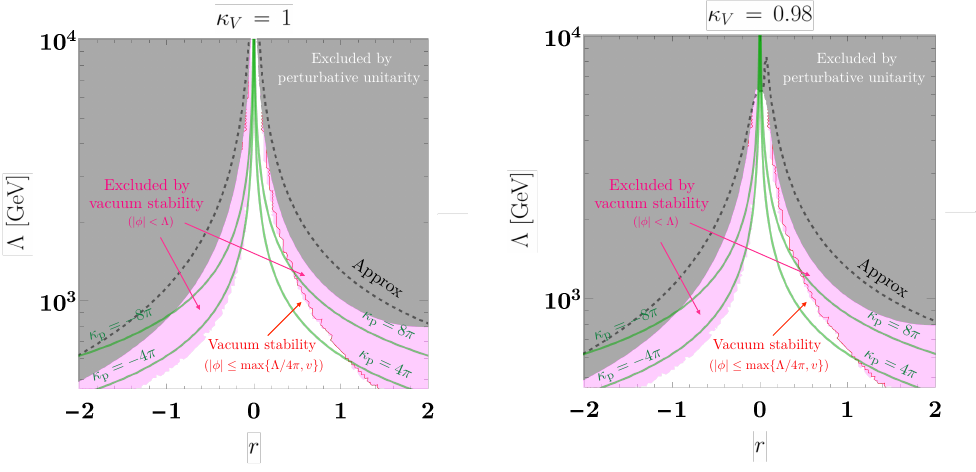
Figure 4 . Perturbative unitarity bound (Gray) and vacuum stability bound (Magenta) for the simple case discussed in section 5.1. We take κ upper bound on the cutoff scale if either κ